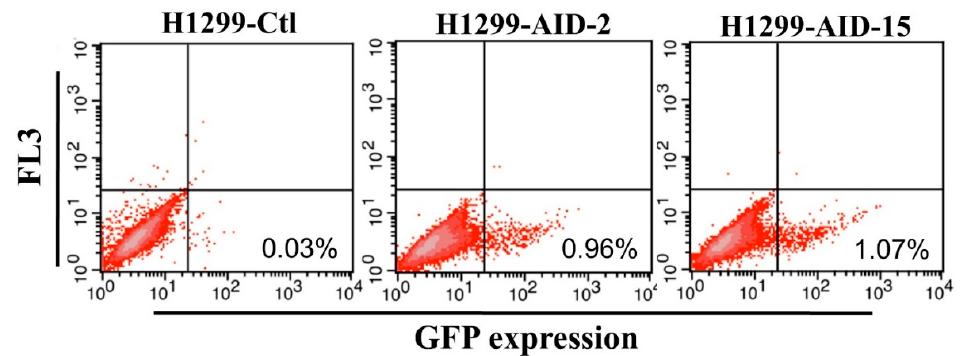
Figure 1. H1299-AID cell clones reverse mutation rate (Clone 2 and Clone 15). H1299-AID clones were transfected with pCEP4-GFPm. 2 days after transfection, the GFP fluorescence (reverse mutation)